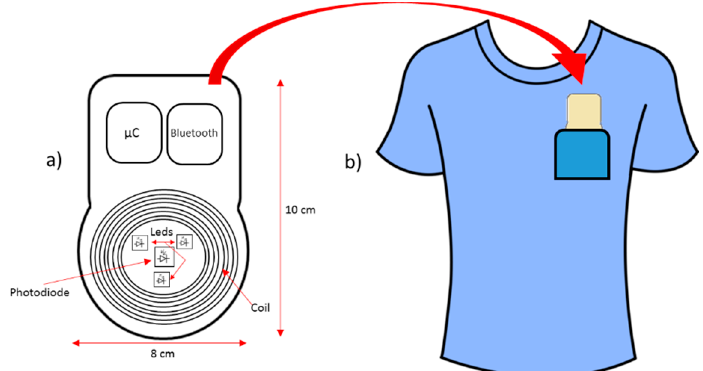
Figure 12. Model of a system for measuring lung volume through an inductive sensor and PPG, featured ( a ) its circuit and ( b ) its size to be placed in the pocket.